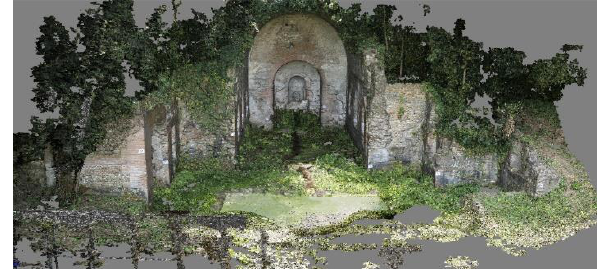
Figure 5. Dense point cloud of the Nymphaeum of Egeria